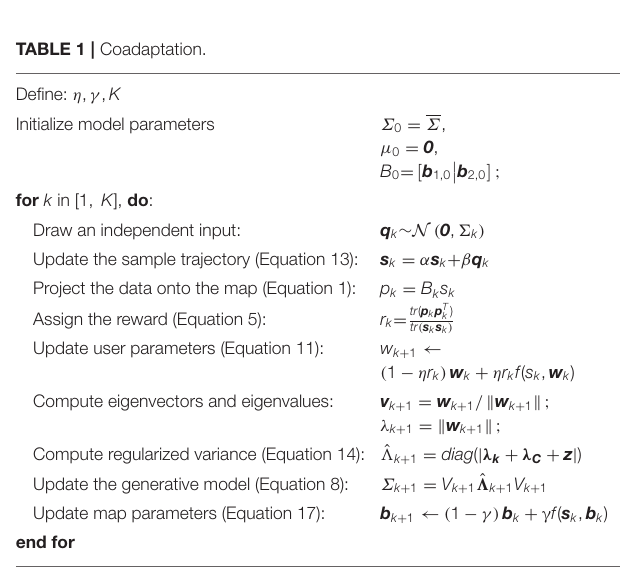
FIGURE 2 | Experimental vs. simulated data. From left to right: normalized orientation data from one channel of IMU recordings while the user controlled the position of a 2D cursor in a reaching task with a body-machine interface (black line) and simulated sensor data channel extracted from a distribution with the same mean and covariance matrix (gray line); autocorrelation function of the experimental and simulated signal cropped at a lag of 500 samples; single-sided amplitude spectrum of the experimental and simulated signal assuming a sample frequency of 50Hz.